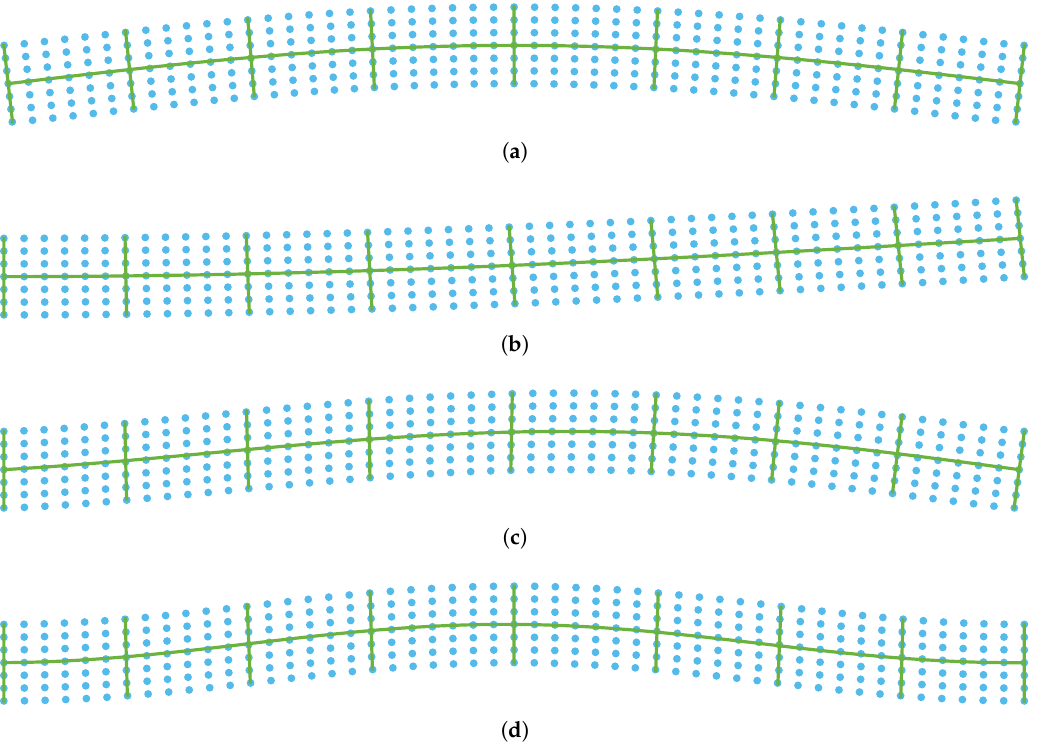
Figure 4. Critical mode in the case study I, when n = 50, and for different boundary conditions: ( a ) H-R; ( b ) C-F; ( c ) C-R; ( d ) C-S. Continuous green curve: Timoshenko model; blue dots: FE